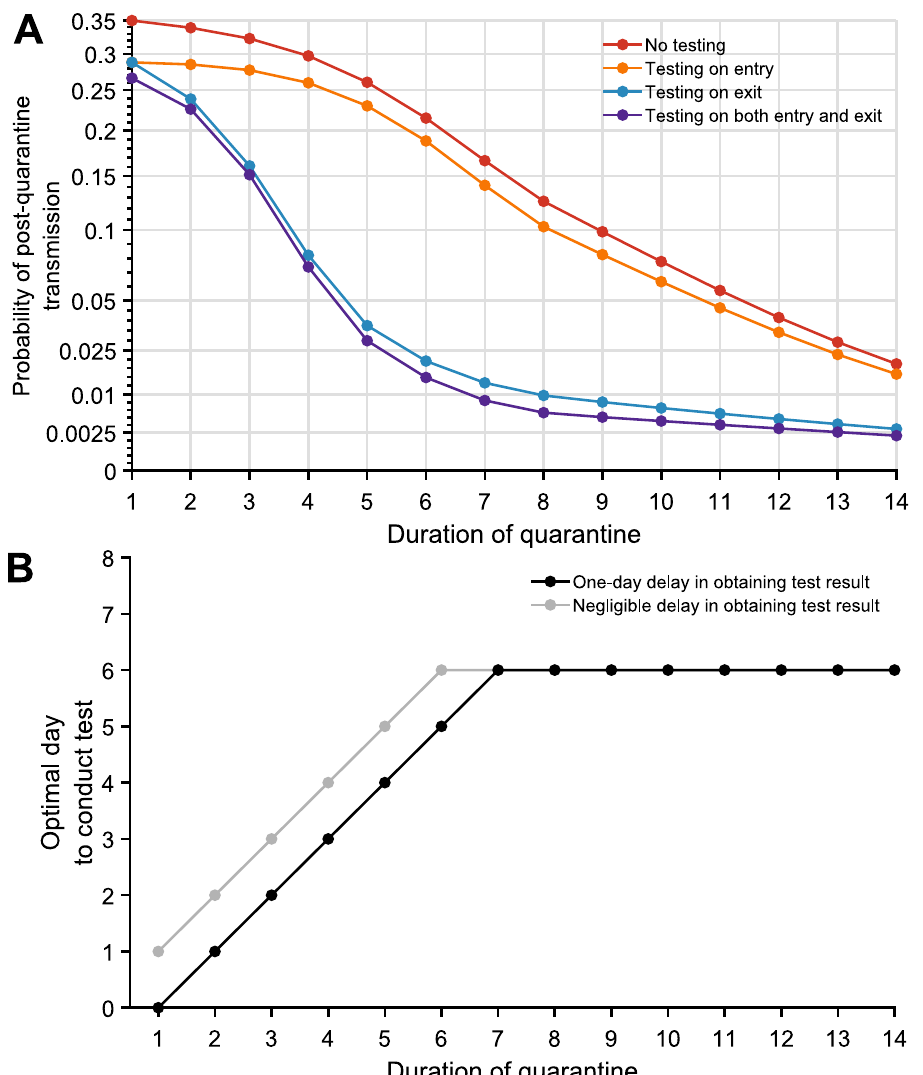
Fig. 3 The impact of testing on the post-quarantine transmission for traced contacts. The probability of post-quarantine transmission for no testing and three testing strategies applied to 1 – 14-day durations of quarantine, when an individual enters quarantine through contact tracing, specifying an incubation period of 8.29 days, 30.8% asymptomatic infections, and perfect self-isolation of symptomatic infections. A Curves for the probability of post-quarantine transmission (one or more post-quarantine infections) without testing (red), with testing upon entry to quarantine (orange), on exit from quarantine (blue), and on both entry to and exit from quarantine (purple), incorporating with all testing strategies a 1-day delay in sample collection to results, such that testing on exit occurred the day before the end of quarantine. B The optimal day to test during quarantine for a speci fi ed quarantine duration, with a 1- day delay (black) and with a negligible delay (gray) in obtaining test